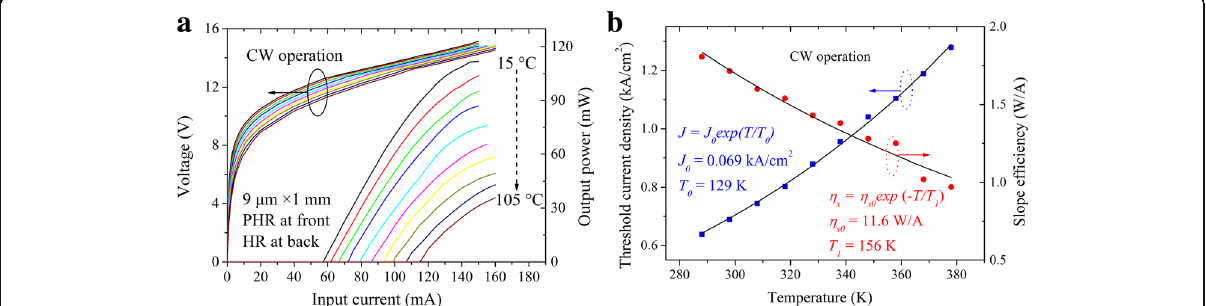
Fig. 3 a CW PIV characterization of the 1-mm-long PHR and HR-coated DFB QCL and b the J th and η s as the functions of the heat sink